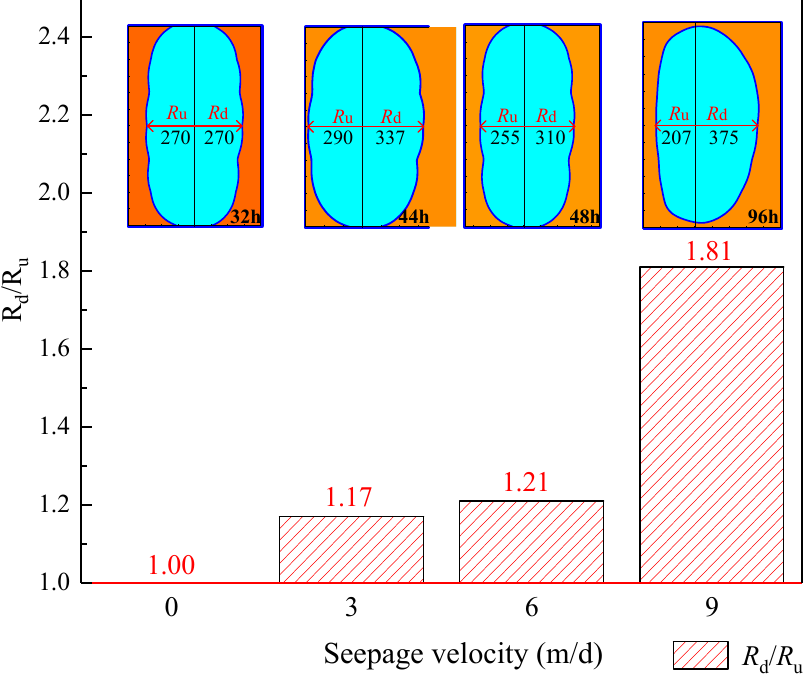
Figure 4. Variation of R d/ R u ratio with seepage velocity.